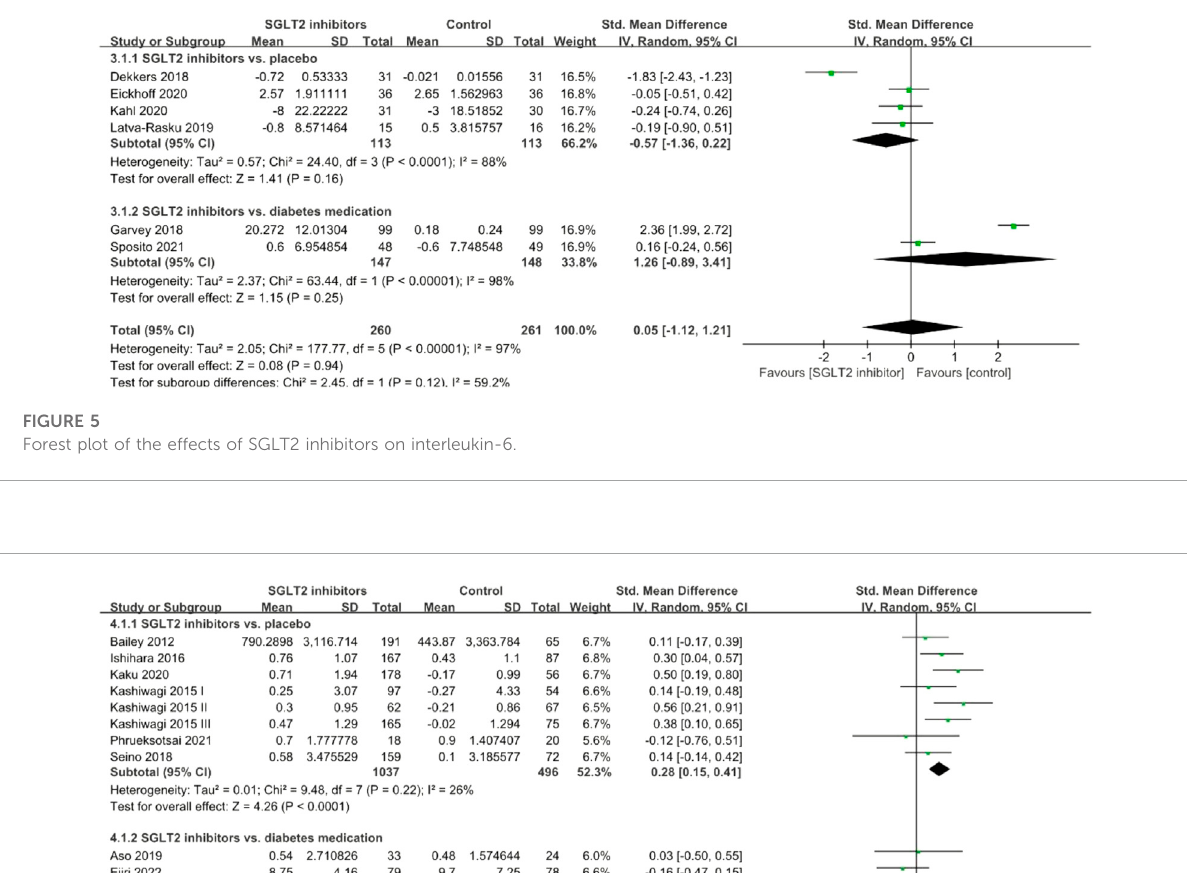
TNF- α A total of seven studies explored the effects of SGLT2 inhibitors on serum TNF- α levels, and no signi fi cant effect was observed (SMD = 0.41; 95% CI: − 0.90, 1.73, p = 0.54); but there was signi fi cant between-study heterogeneity ( I 2 = 98%, p < 0.001; Figure 4). Subgroup analyses did not signi fi cantly improve the results. After removal of the study conducted by Garvey et al., the I 2 -value was reduced from 98% to 33%.